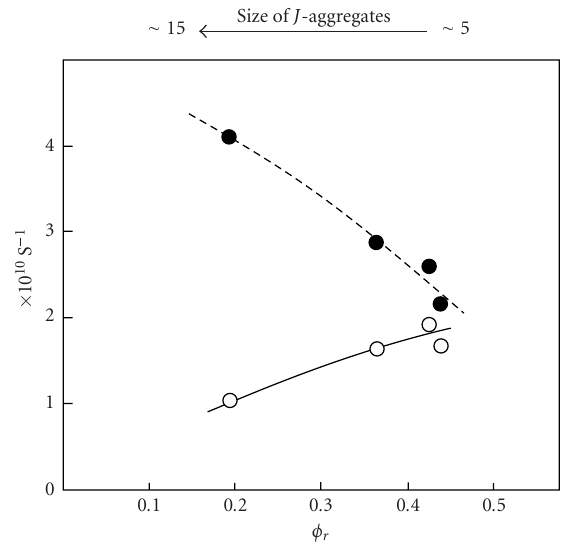
Figure 7: The rate constants of the electron transfer process (ks; (cid:4) ) ) in dye sensitization and competing deactivation processes (kL; (cid:0) of silver bromide grains by the dye in Figure 2. As indicated on the abscissa, the quantum yield of dye sensitization ( Φ r ) decreases with increasing the size of the J -aggregates of the